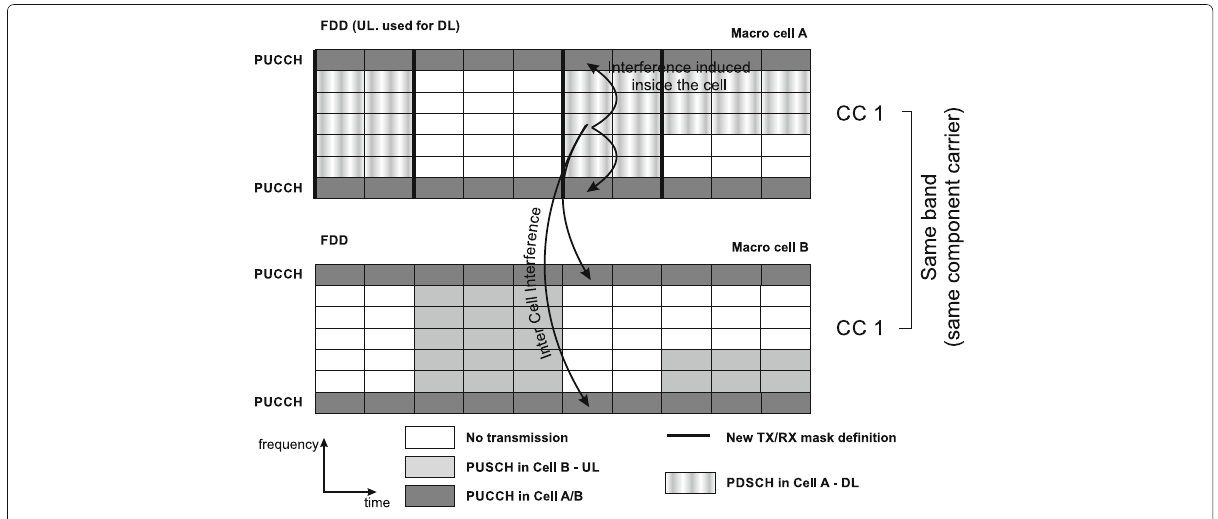
reserved for, so-called, cancellation carriers